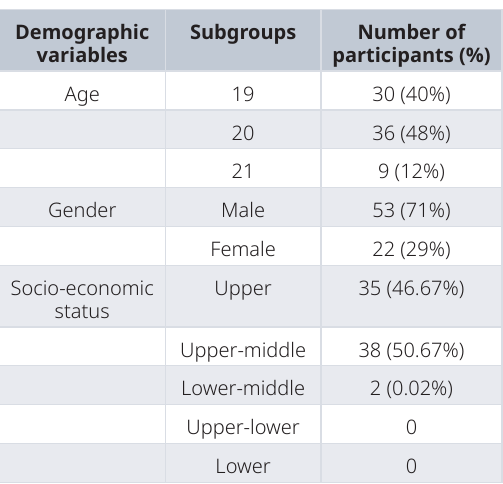
Table 2. Demographic details of the college students